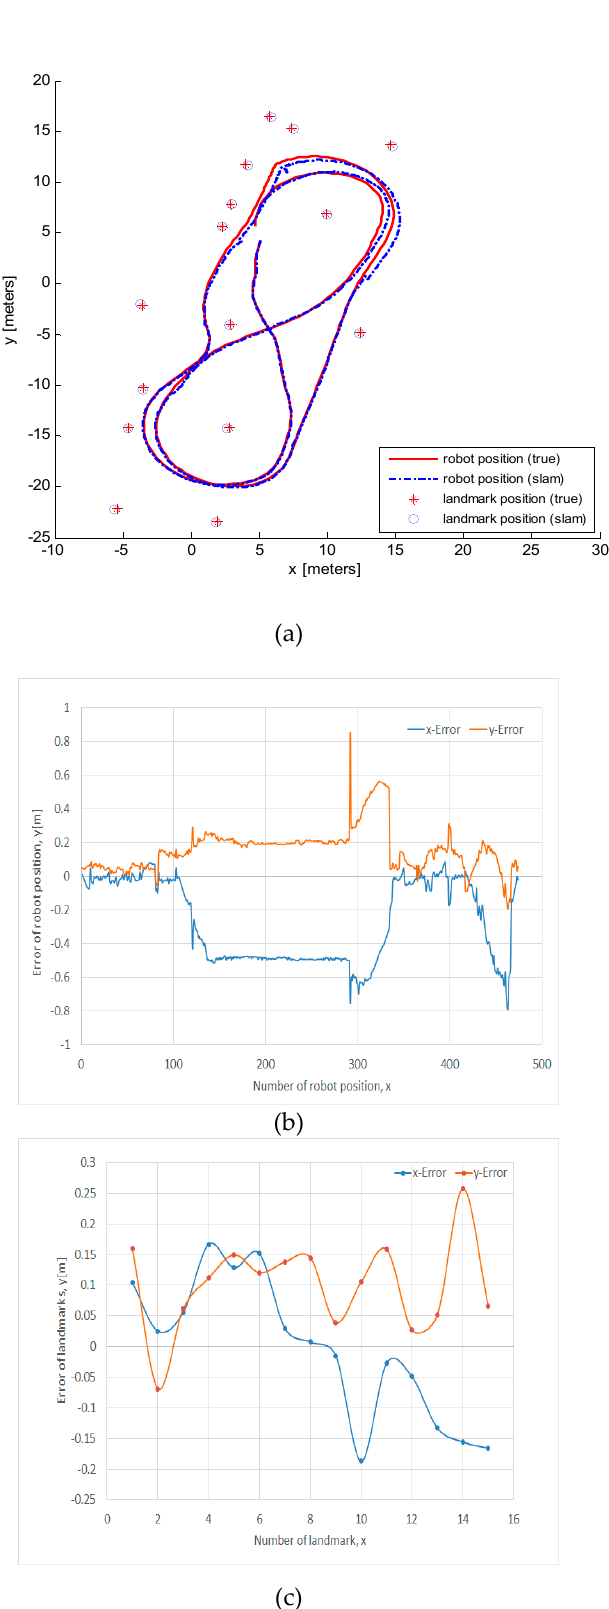
Figure 10. Simulation results for SLAM with a signal-to-noise (SNR) of 65 (dB) in the distance data: ( a ) EKF-SLAM for a mobile robot based on microphone landmark observations; ( b ) robot position errors in the x - and y -directions; and ( c ) landmark position errors in the x - and y -directions.